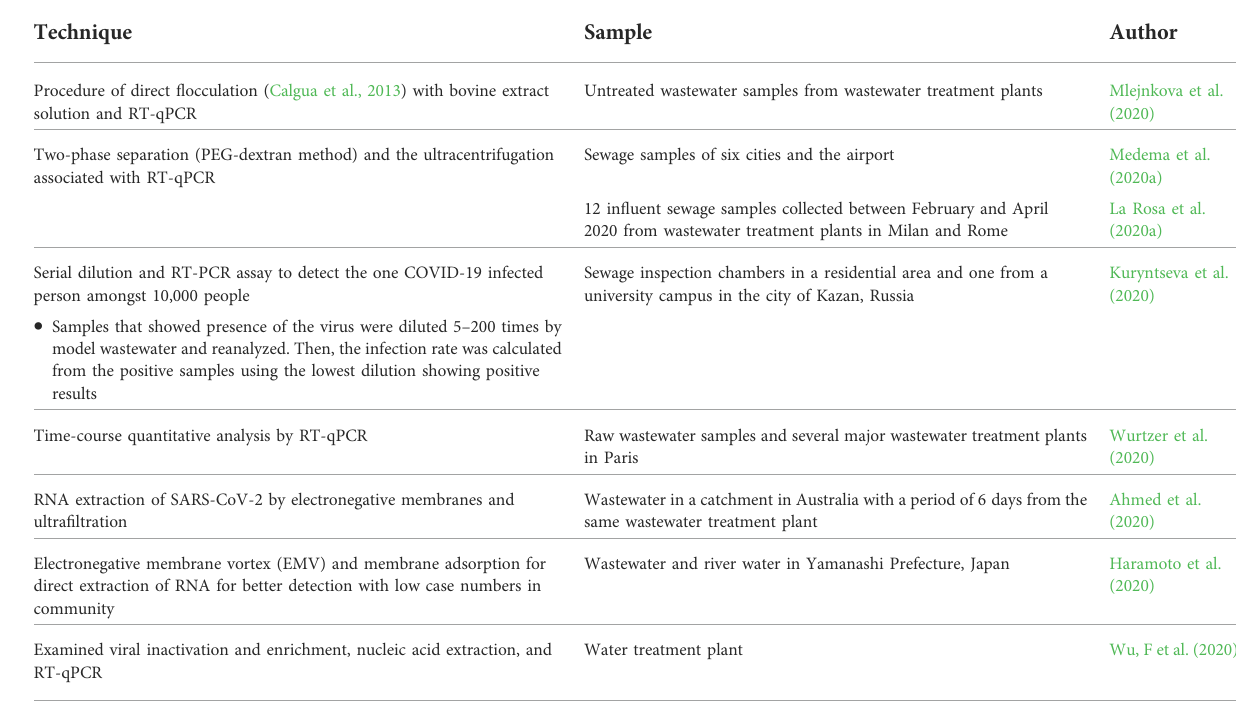
TABLE 4 Different techniques used to examine wastewater for the presence of SARS-CoV-2 or its RNA.